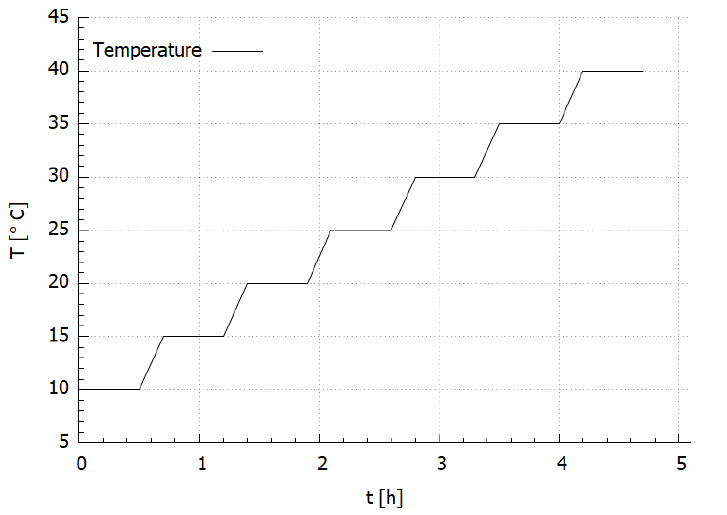
Figure 3. Program of the